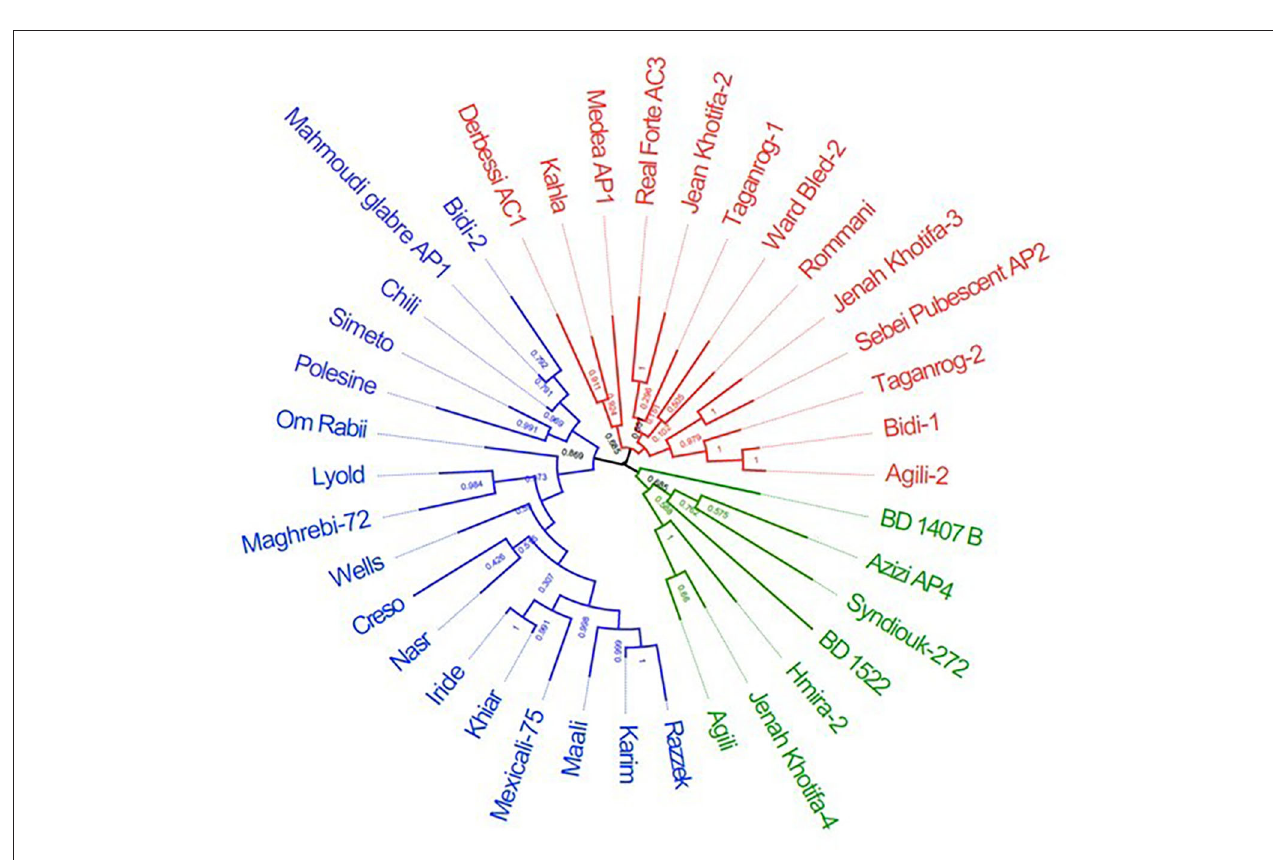
FIGURE 4 | Unrooted tree constructed using maximum likelihood method based on the genetic distances for durum wheats using 5,555 SNPs. The samples are colored in blue (modern durum cultivars, MDC), red (Tunisian durum landraces group 1, TDL-1), and green (Tunisian durum landraces group 2, TDL-2).